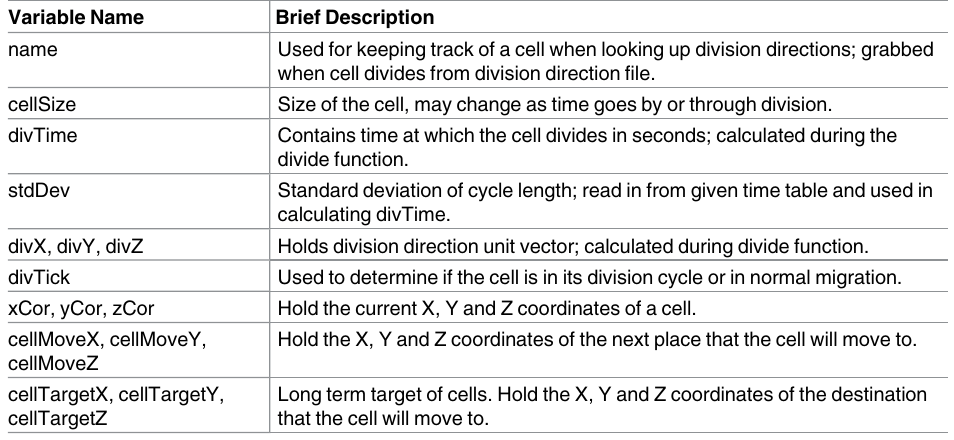
Table 1. Agent variables used in